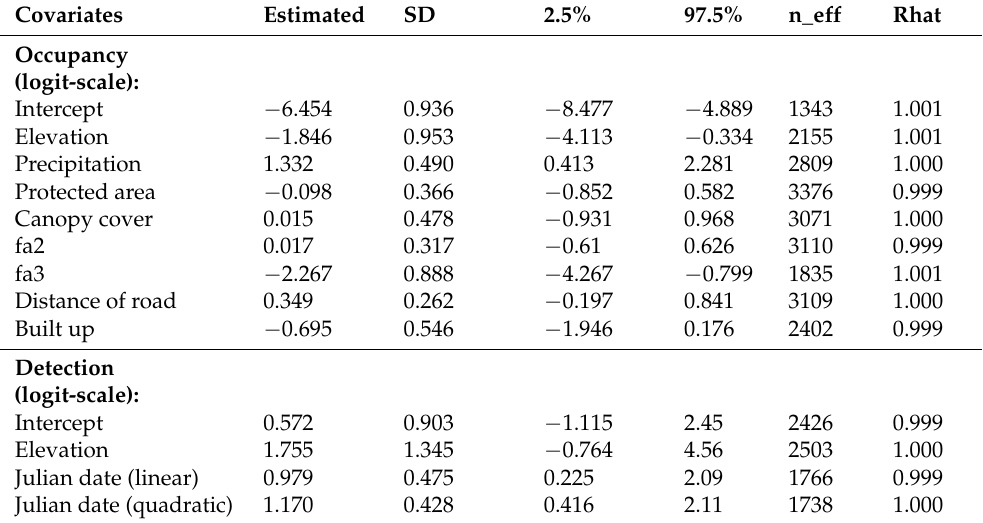
Table A7. Output summary from the best spatial occupancy model ( ψ (intercept + elevation + precipitation + protected area + canopy cover + fa2 + fa3 + distance of road + built up); ρ (intercept + elevation + Julian day + Julian day 2 )) of American bullfrog ( Lithobates catesbeianus ) in Puerto Rico. Note: fa2 = proportion of forest cover aged between 32 and 54 years; fa3 = proportion of forest cover aged 55 years and older. Runtime: 40.292 min.